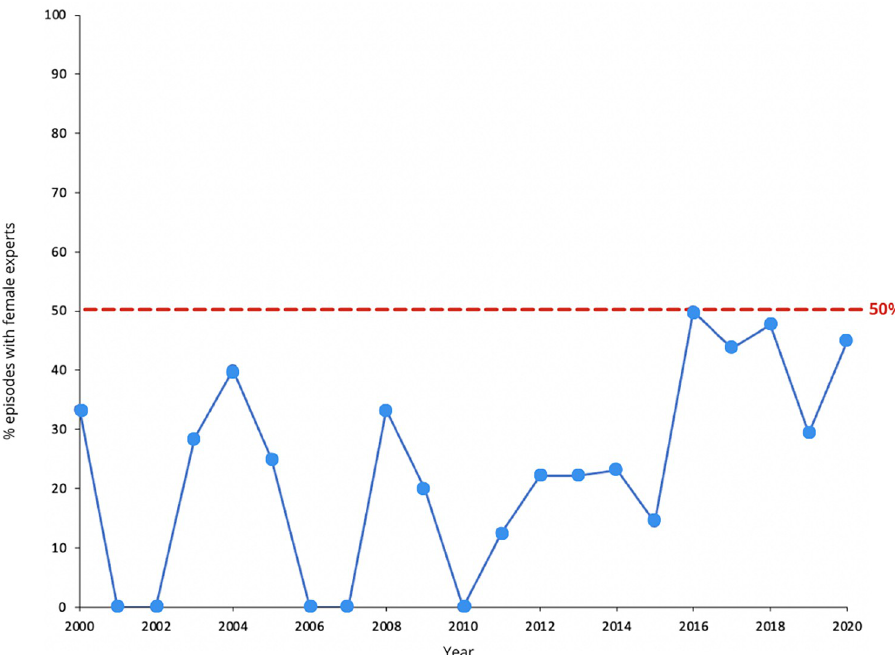
Fig 6. Percent of episodes including any appearance by an expert/host referred to by female pronouns, by year. The red dashed line indicates 50% for a given year. Overall, 20.1% of hosts/experts were associated with female